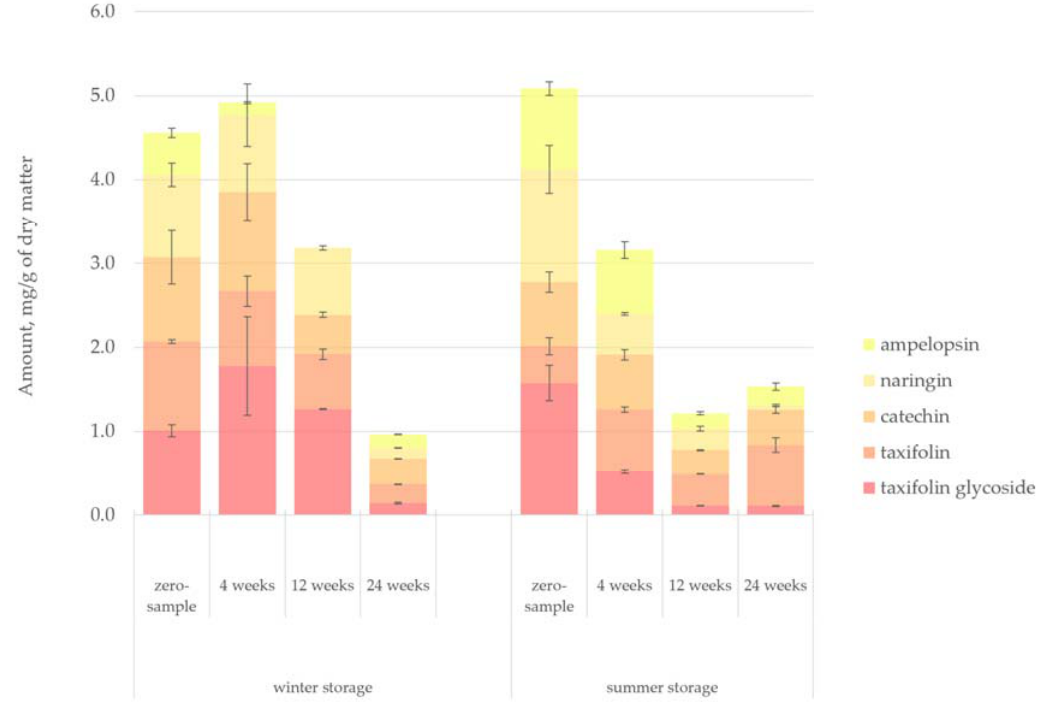
Figure 15. Changes in flavonoids during summer and winter storage periods of saw log bark.